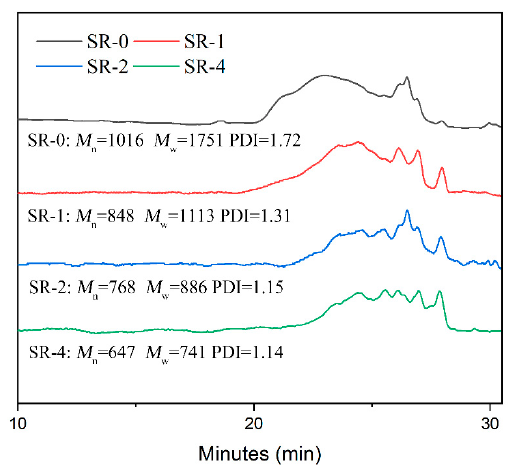
Figure 2. 29 Si NMR of the silicon resins.